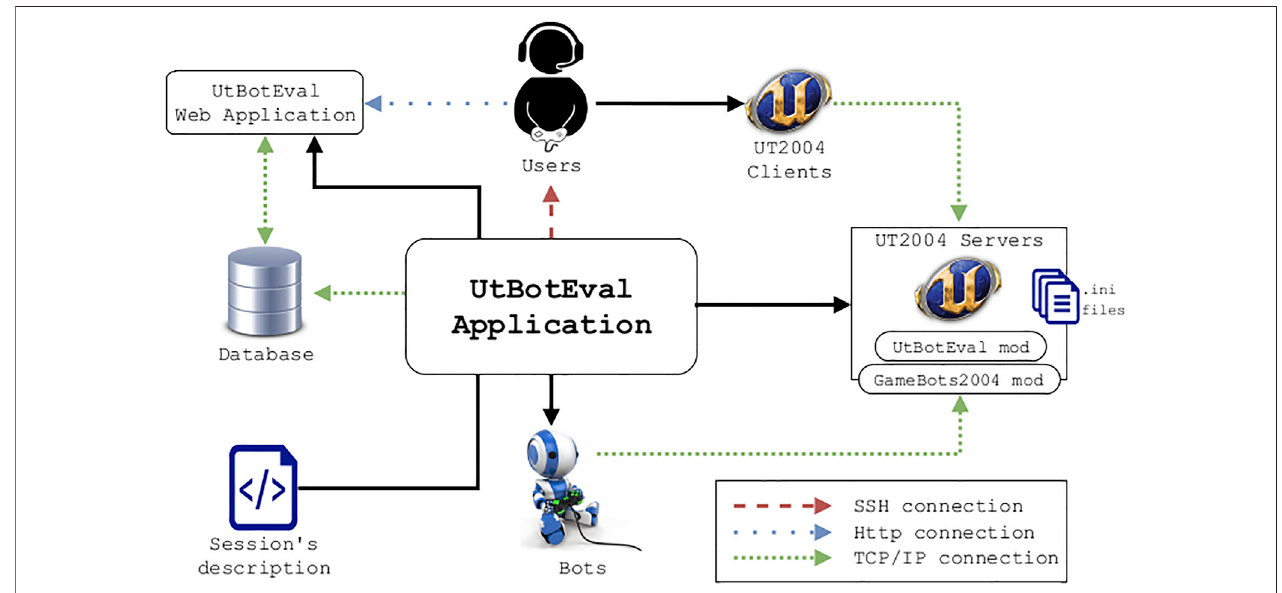
FIGURE 1 | System architecture of the UtBotEval